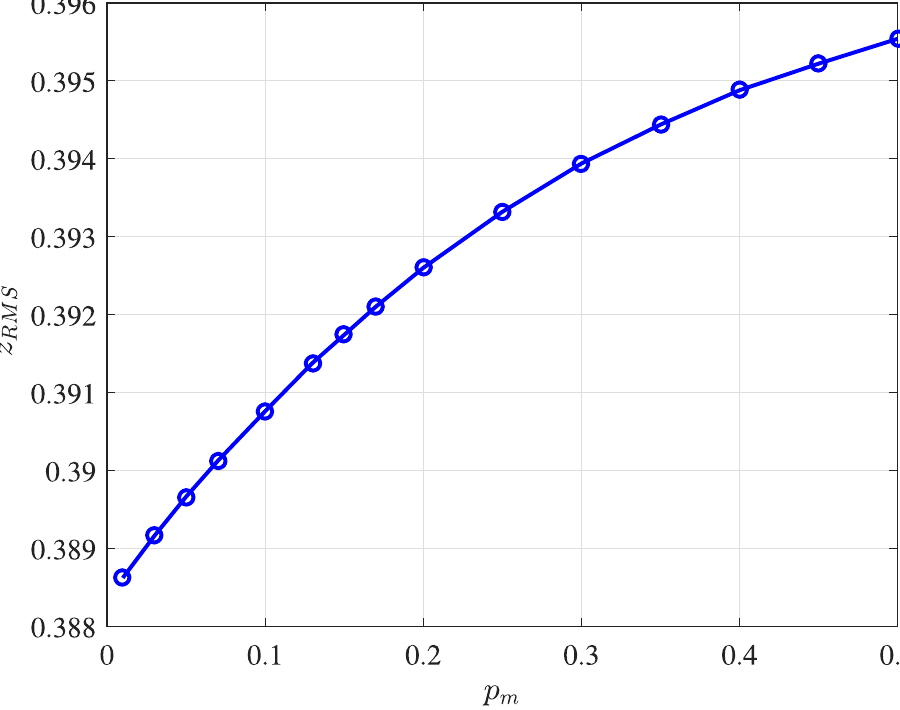
Figure 11. Relationship between the quadrotor weight and trajectory performance during the take- off phase.